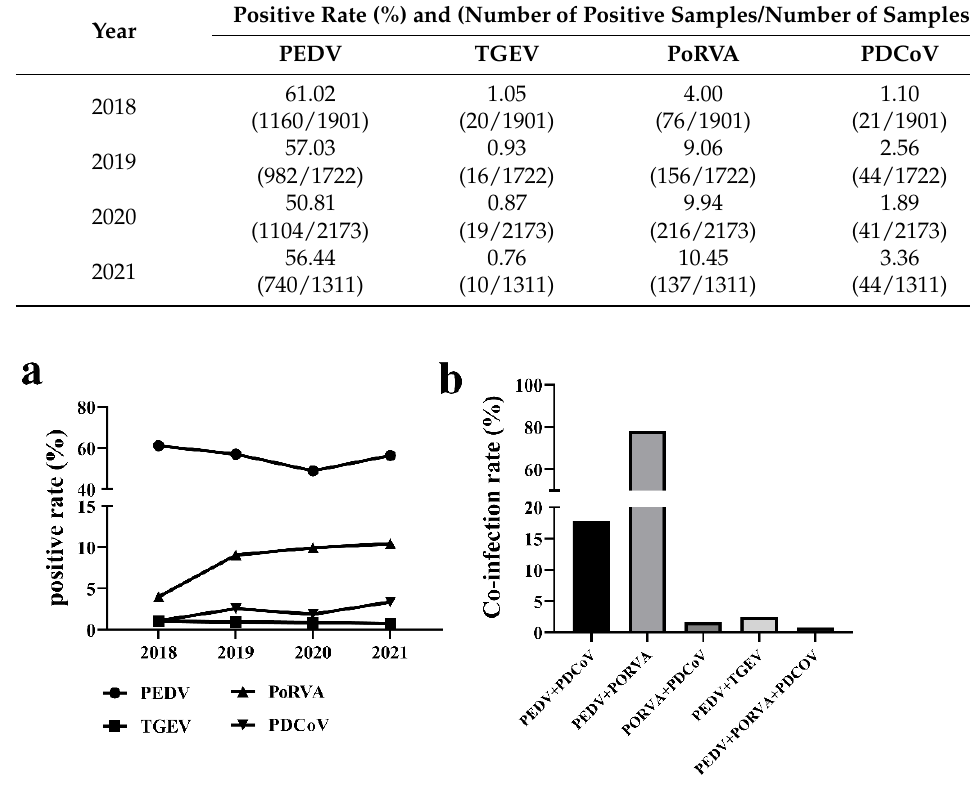
Figure 1. Positive rate of swine enteric viruses from 2018 to 2021. ( a ) Variation trend of the positive rate of diarrhea virus from 2018 to 2021. The X -axis represents the year, and the Y -axis represents the positive rate of PEDV, TGEV, PoRVA, and PDCoV. ( b ) Co-infection rate of swine enteric viruses in samples collected from 2018 to 2021. The X -axis represents the pattern of co-infection, and the Y -axis represents the co-infection rate.